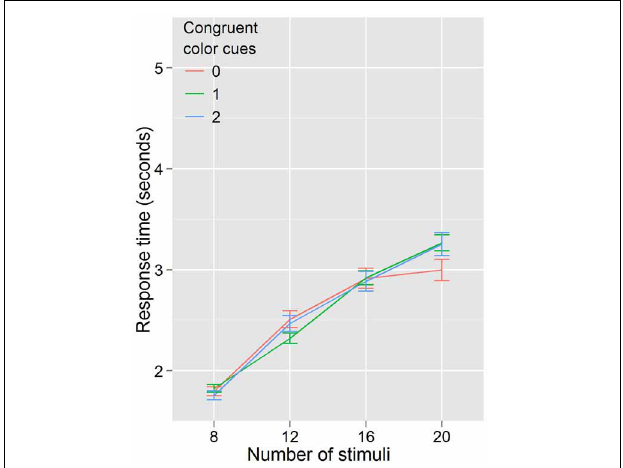
FIGURE 5 | Response times by distractor number for Experiment 3. Search efficiency is modulated by conditional probability even when color priming is